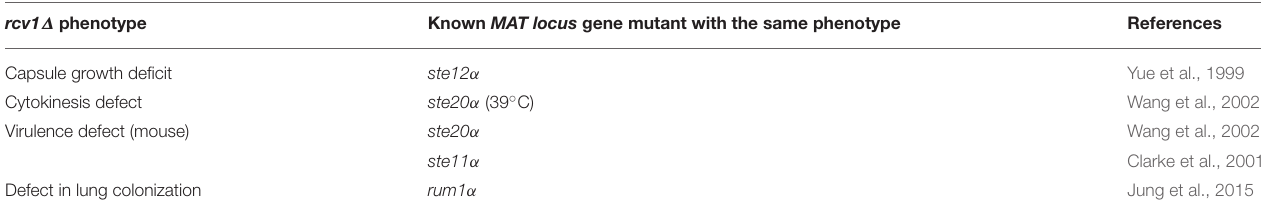
TABLE 2 | Correspondence between observed phenotypes of the rcv1 ∆ strain and those of other MAT α locus gene mutants. rcv1 ∆